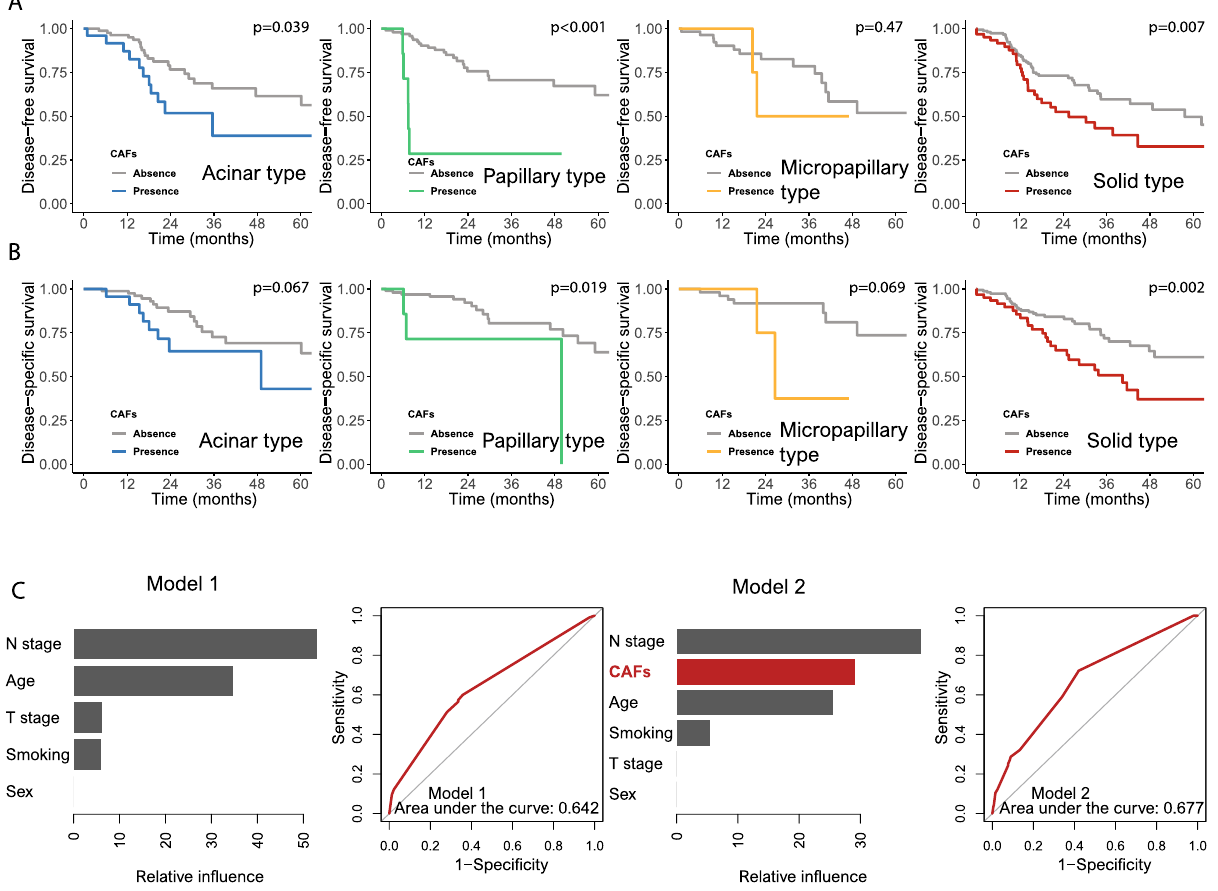
Figure 5. Survival analyses of the four types based on the absence or presence of cancer-associated fibroblasts. ( A ) Disease-free survival: acinar, papillary, micropapillary and solid types ( p = 0.039, < 0.001, = 0.47 and 0.007, respectively). ( B ) Disease-specific survival: acinar, papillary, micropapillary and solid types ( p = 0.067, 0.019, 0.069 and 0.002, respectively). ( C ) We supervised machine-learning models for prognosis prediction using gradient boosting machine (GBM). Covariates were included in the confounding factors [Model 1 (left); T stage, N stage, age, sex, smoking (pack years) versus Model 2 (right); Cancer associated fibroblasts (CAFs), T stage, N stage, age, sex, smoking (pack years)] and their relative importance using overall survival. Receiver operator characteristic curve for GBM was used based on a multivariate Gaussian